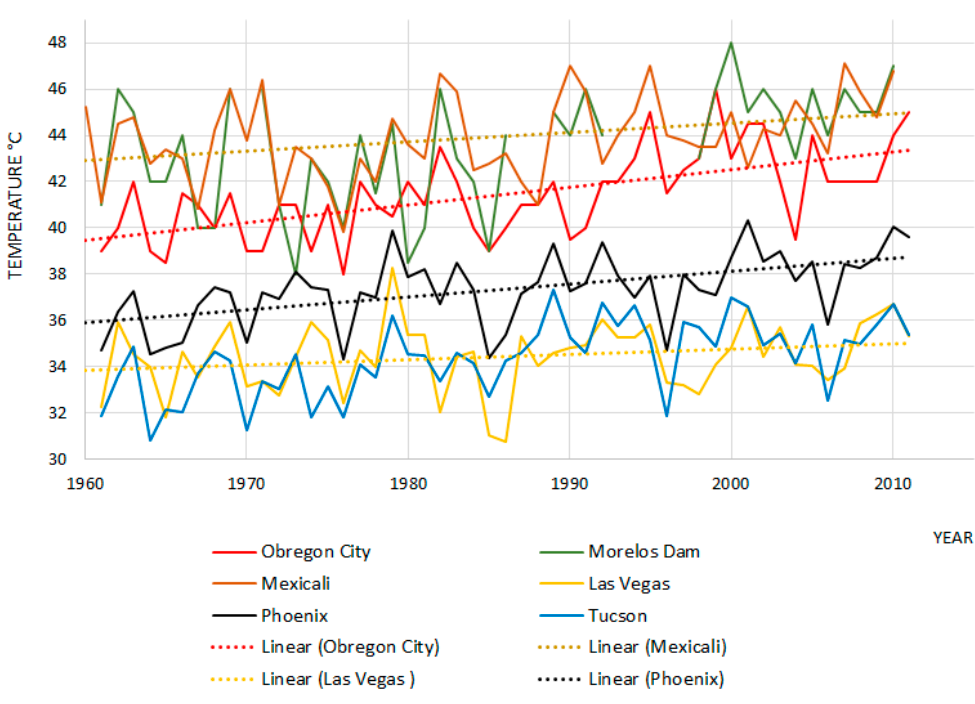
Figure 3. Maximum monthly temperature variations and linear trend lines for September.